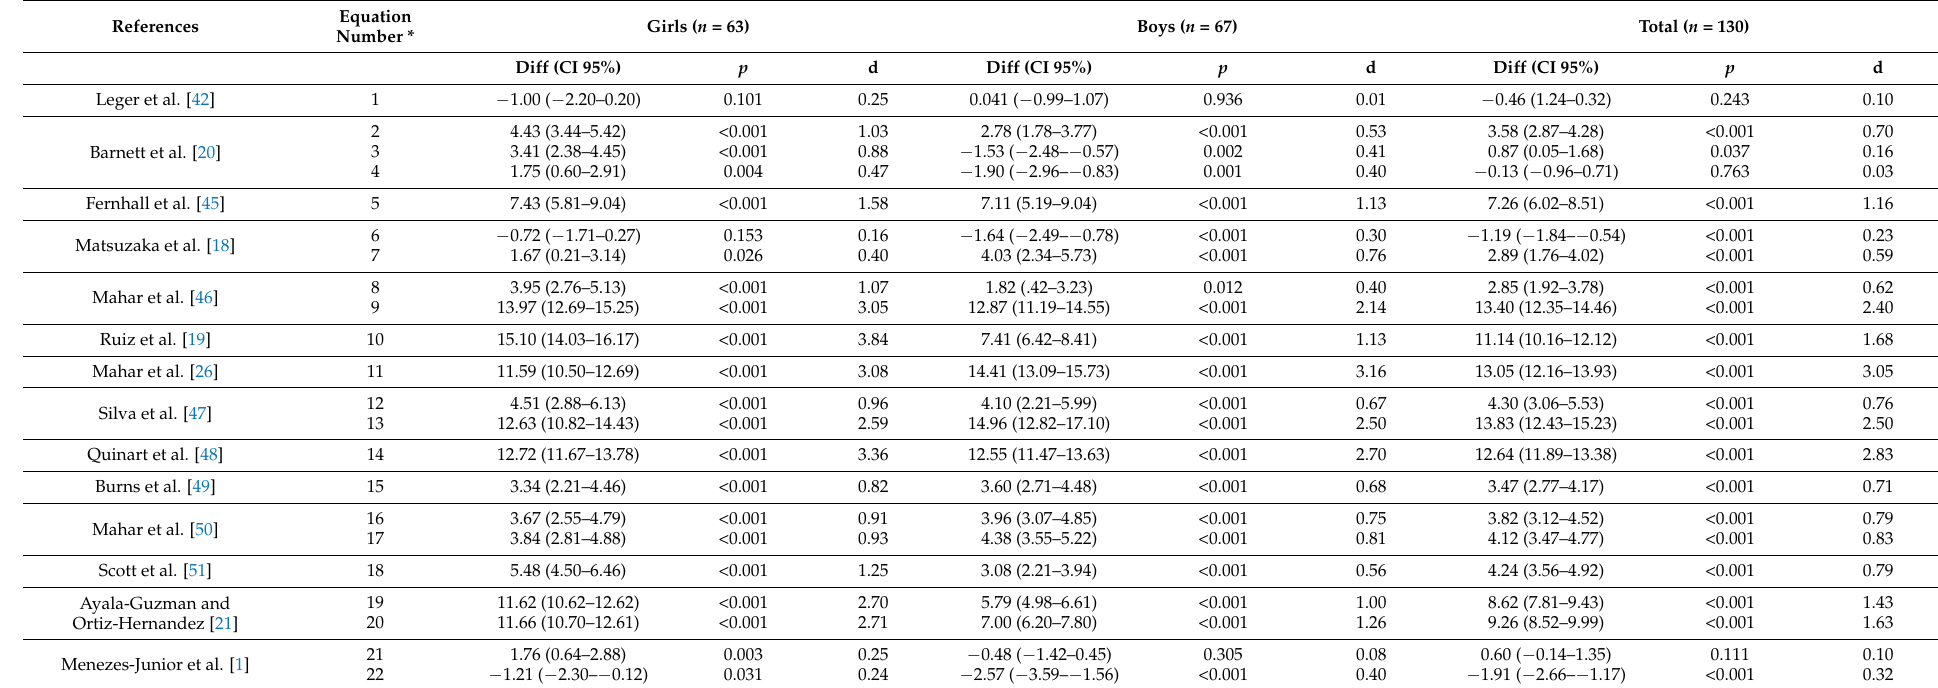
Table 5. Comparisons between the measured VO 2 peak values and predited VO 2 peak values using